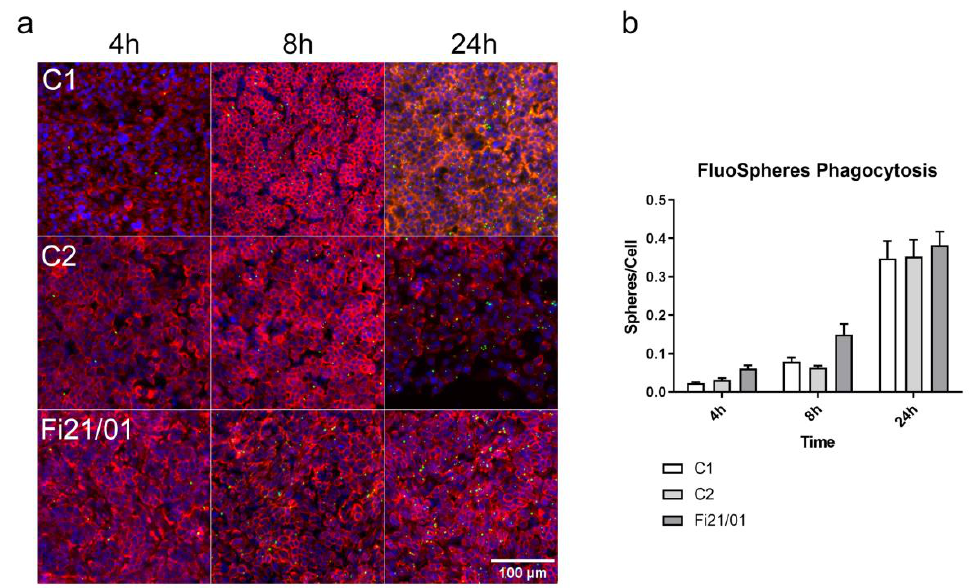
Figure 6. Phagocytosis capacity determination in iPSC-RPE cells. ( a ) Immunofluorescence images of both controls and Fi21/01 iPSC-RPE cells with nuclei staining (blue) and phalloidin-555 (red) and the internalized green-yellow FluoSpheres at different times. ( b ) Quantification of the number of spheres/number of cells at different times (4 h, 8 h, 24 h) of both controls and Fi21/01 iPSC-RPE. Experiments were performed with 8 to 12 replicates on three independent experiments. Significance was determined by Two-way ANOVA with Bonferroni comparison test and no significant differ- ences were observed. Scale bar: 100 µm.